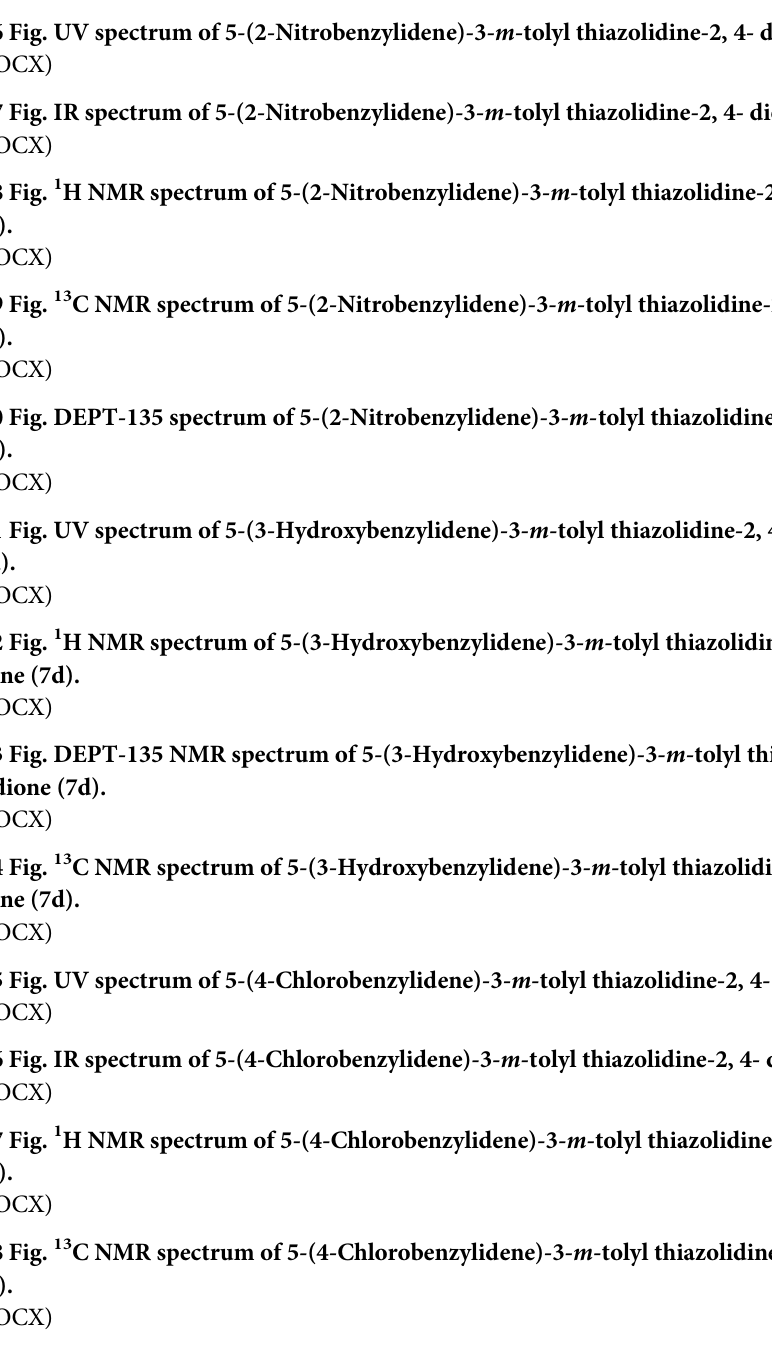
S14 Fig. 13 C NMR spectrum of 5-(2-Chlorobenzylidene)-3- m -tolyl thiazolidine-2, 4- dione (7b). S15 Fig. DEPT-135 spectrum of 5-(2-Chlorobenzylidene)-3- m -tolyl thiazolidine-2, 4- dione (7b). S16 Fig. UV spectrum of 5-(2-Nitrobenzylidene)-3- m -tolyl thiazolidine-2, 4- dione (7c). S17 Fig. IR spectrum of 5-(2-Nitrobenzylidene)-3- m -tolyl thiazolidine-2, 4- dione (7c).